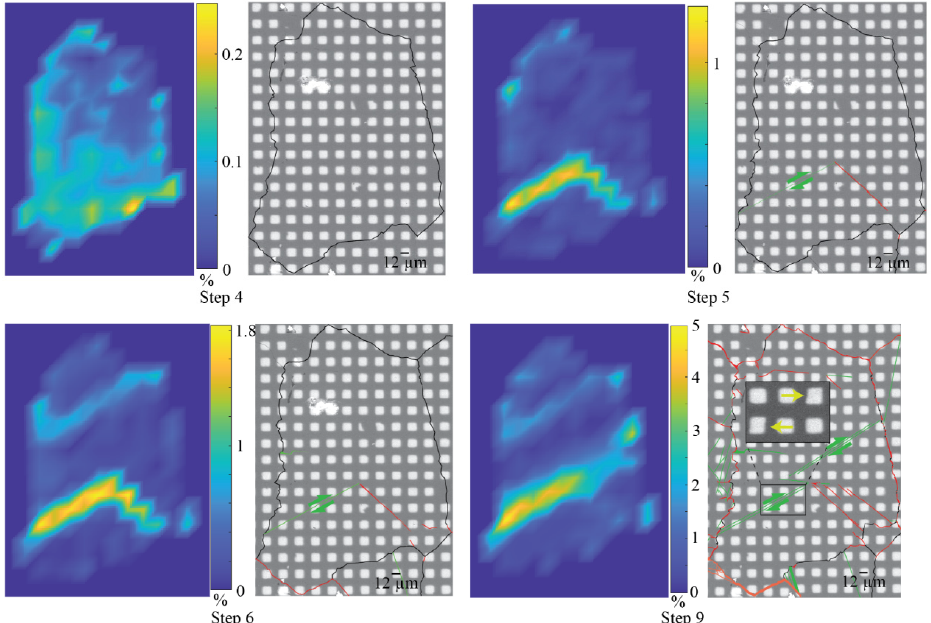
Figure 11. Equivalent Von Mises deformation map of crystal 4 at different steps of sample deformation. The black lines represent the grain boundaries. The green lines show the twinned planes. The red lines show the fracture zones. The yellow arrows show the stretched gold marks compared to the surrounding